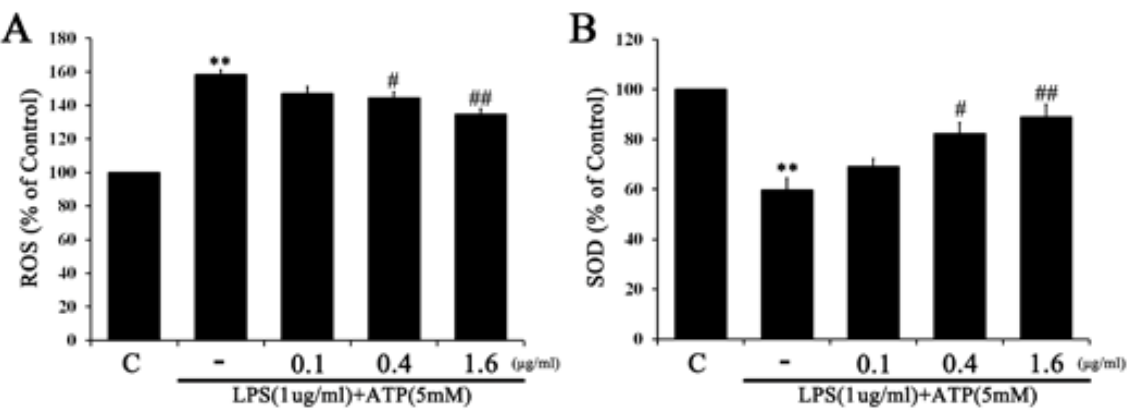
Figure 2. Effect of T β 4 on ROS generation and SOD activity in LPS and ATP-induced RAW264.7 cells. RAW264.7 were pretreated with T β 4 (0.1, 0.4, and 1.6 µ g/mL) for 1 h, followed by NLRP3 inflammasome induction using LPS (1 µ g/mL) for 4 h and ATP (5 mM) for 30 min. ( A ) ROS generation was evaluated by DCF-DA. ( B ) SOD expression was measured by ELISA in the cell lysates. Data are presented as mean ± SEM ( n = 3). ** p < 0.01 compared with the C. # p < 0.05 compared with the LPS and ATP-treated group. ## p < 0.01 compared with the LPS and ATP-treated group. We examined the effect of T β 4 on the production of ROS in the LX ‐ 2 cell line. Various